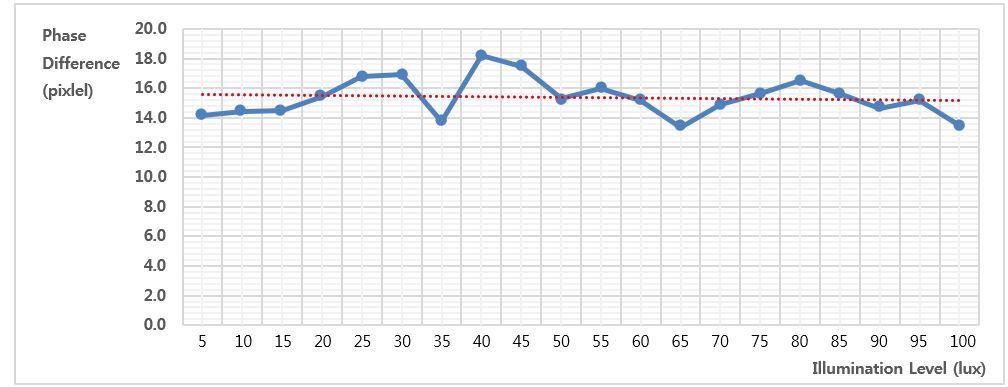
Figure 17. Results of motion estimation for different illumination levels (the unit of the vertical axis is in pixels, and that of the horizontal axis is in